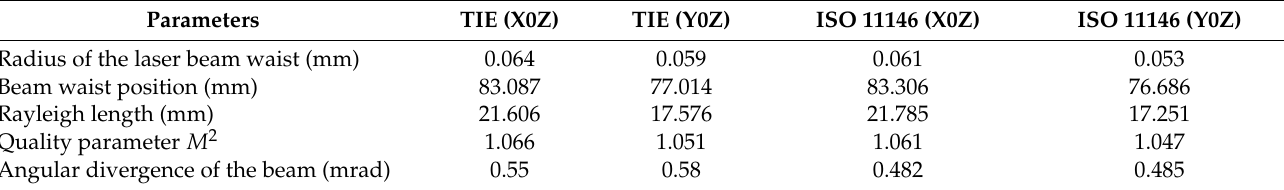
Table 3. Spatial parameters of the Satsuma laser beam.